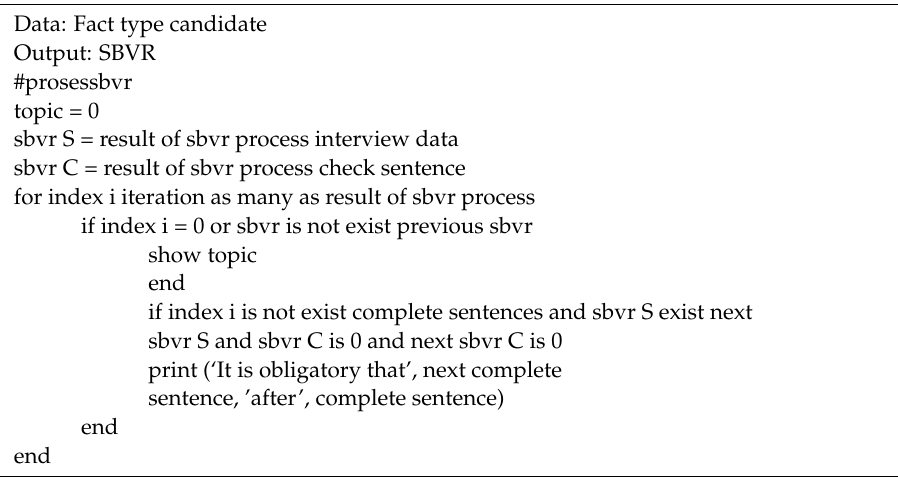
Algorithm 7. Fact type operational rule in